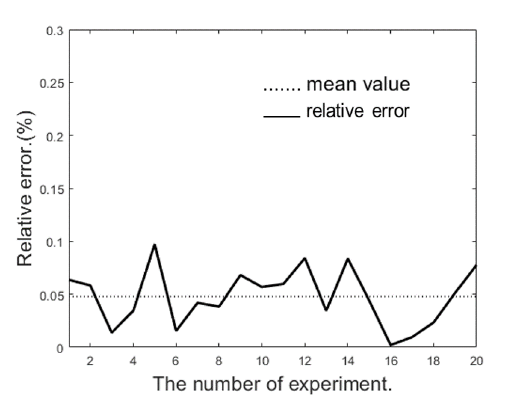
Figure 17. The relative error when input voltage amplitude is imbalance.